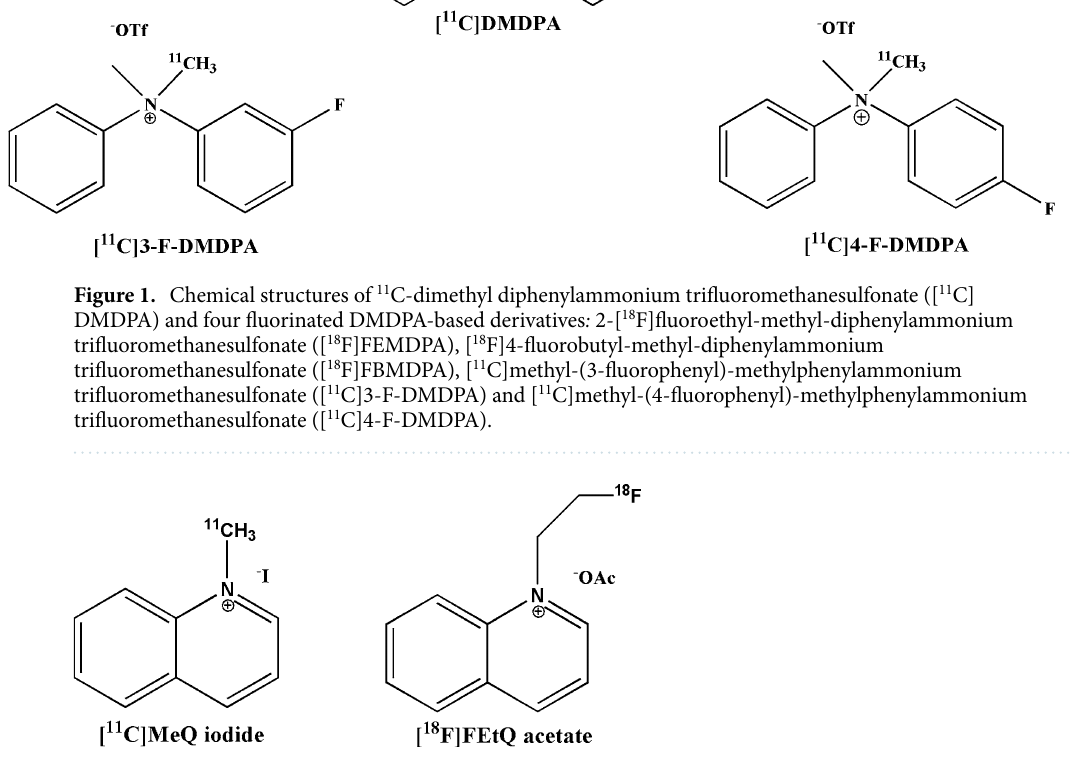
Figure 2. Chemical structures of [ 11 C]methylquinolinium iodide ([ 11 C]MEtQ) and [ 18 F]fluoroethylquinolinium acetate ([ 18